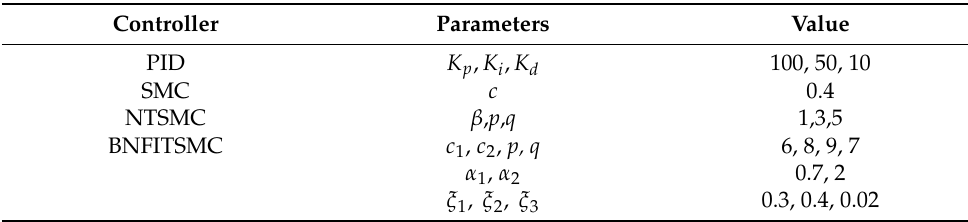
Table 4. The selected parameters of the